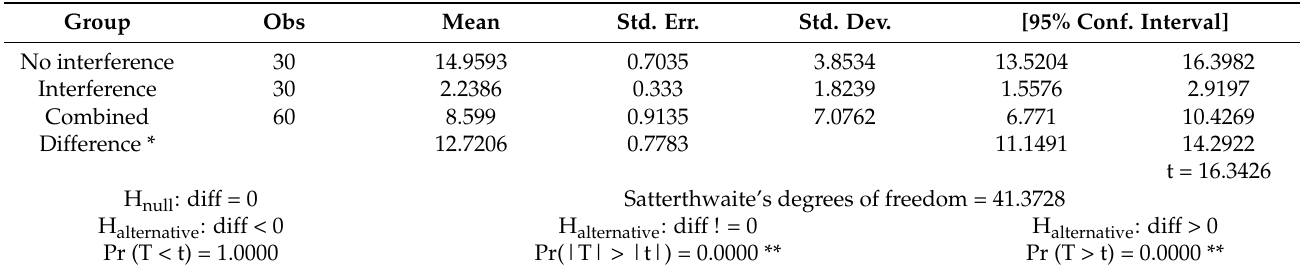
Table 7. Comparison of upload throughput between the control and interference scenarios based on a t